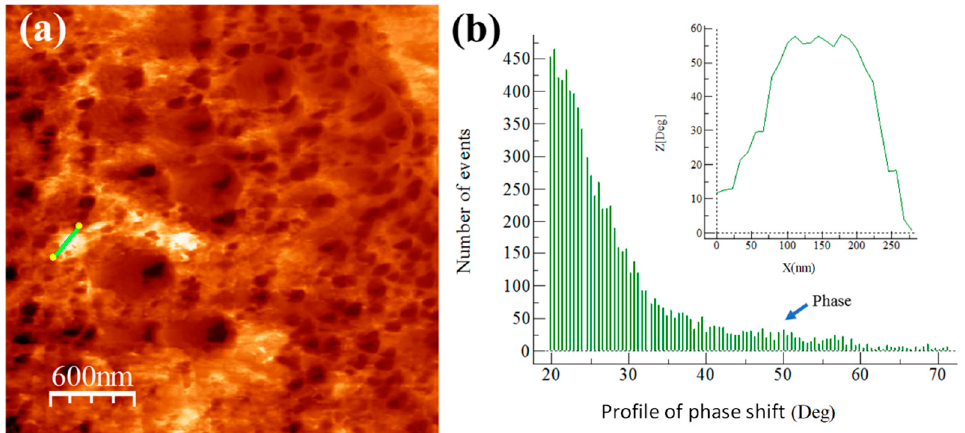
Figure 7. Alp-Mg master compound sample image: ( a ) AFM tapping mode image and ( b ) degree distribution profile of phase shift and distribution profile of a corresponding continuous line that crosses the bright area in the phase image (shown inset of the figure).